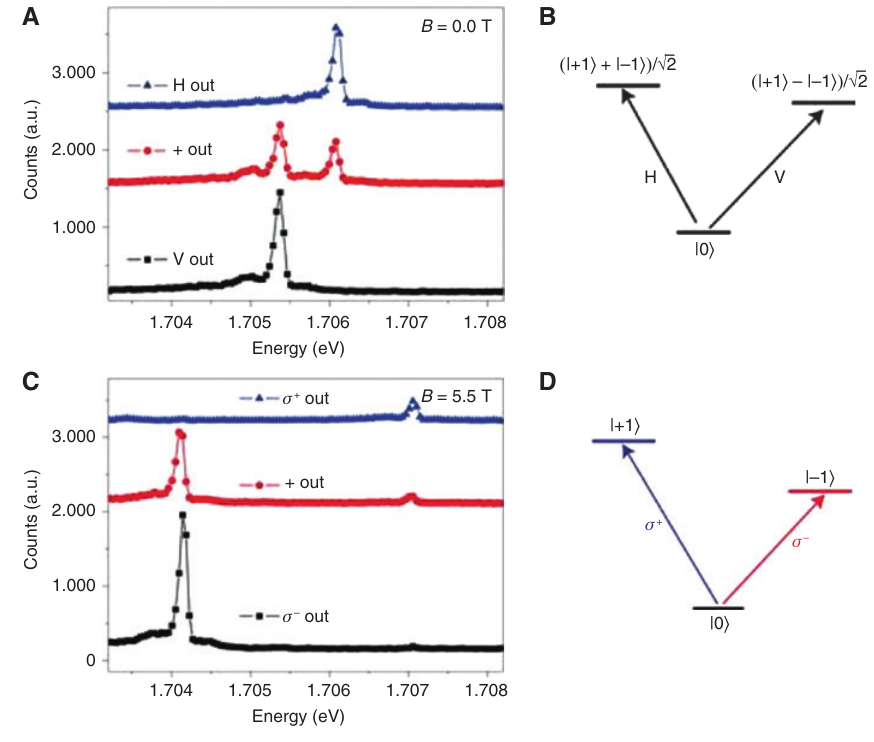
Figure 3: Polarization-resolved photoluminescence. (A) Polarization-resolved PL spectra of an exemplary quantum emitter in WSe at zero magnetic field showing a cross-linearly polarized 2 doublet. (B) Zero-field energy-level diagram with linearly polarized optical selection rules. (C) At a magnetic field of 5.5 T, the doublet becomes cross-circularly polarized. (D) Its energy-level diagram. H, V, σ + , σ − , and + denote the horizontal, vertical, left-circular, right- circular, and 45 ° linear polarization, respectively. Reproduced with permission from Ref. [6], Nature Publishing